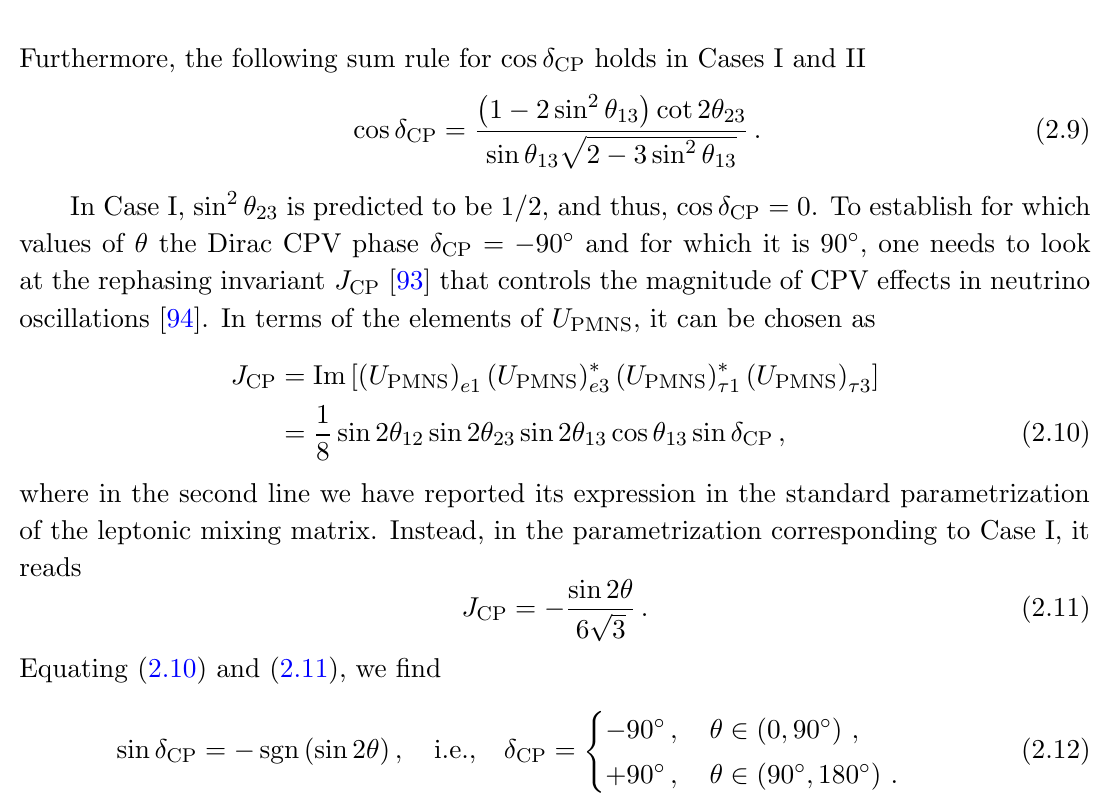
CP derived in (cid:2)